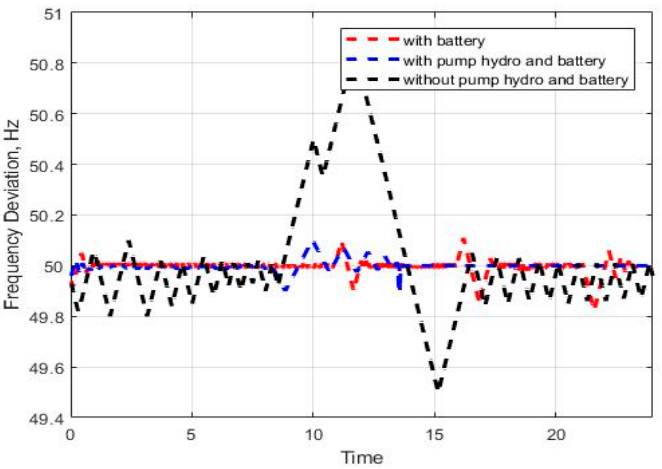
Figure 6. Frequency response of the microgrid without solar power full-day.